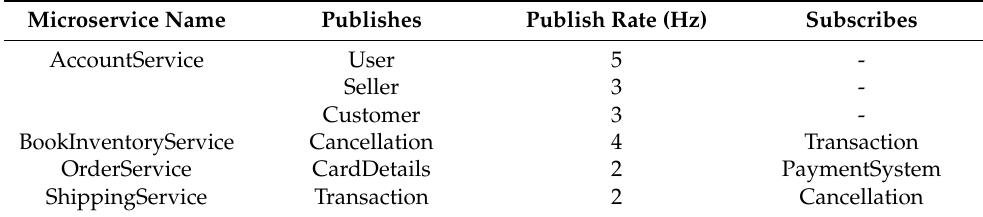
Table 2. Publish/subscribe relation schema for the case